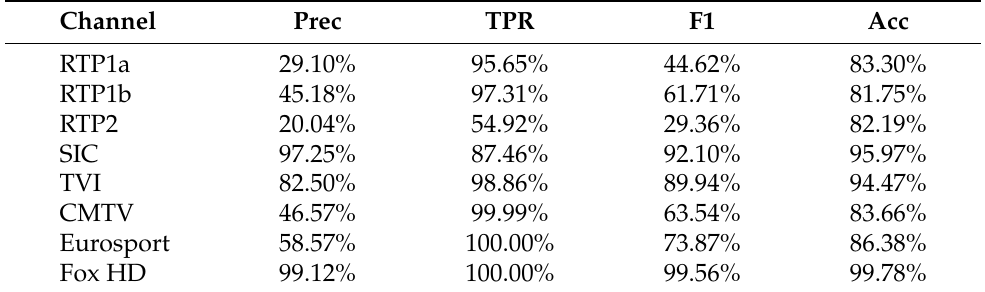
Table 5. Results obtained for the annotated dataset, analyzing the advertisement